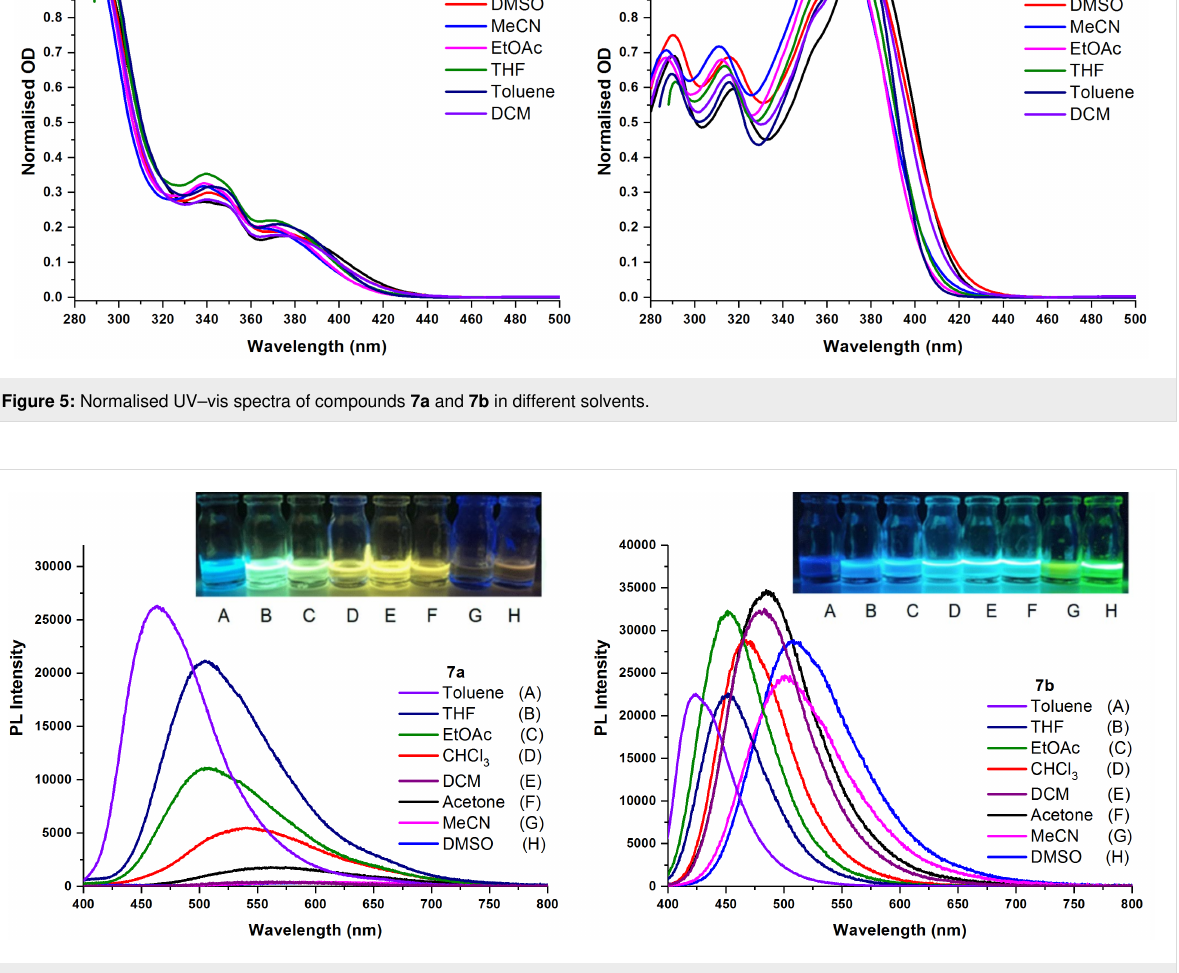
Figure 6: PL spectra of compounds 7a and 7b in different solvents